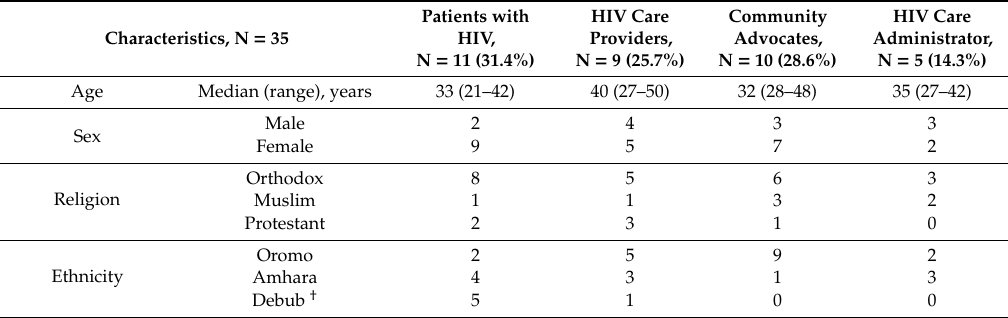
Table 1. Demographic characteristics of